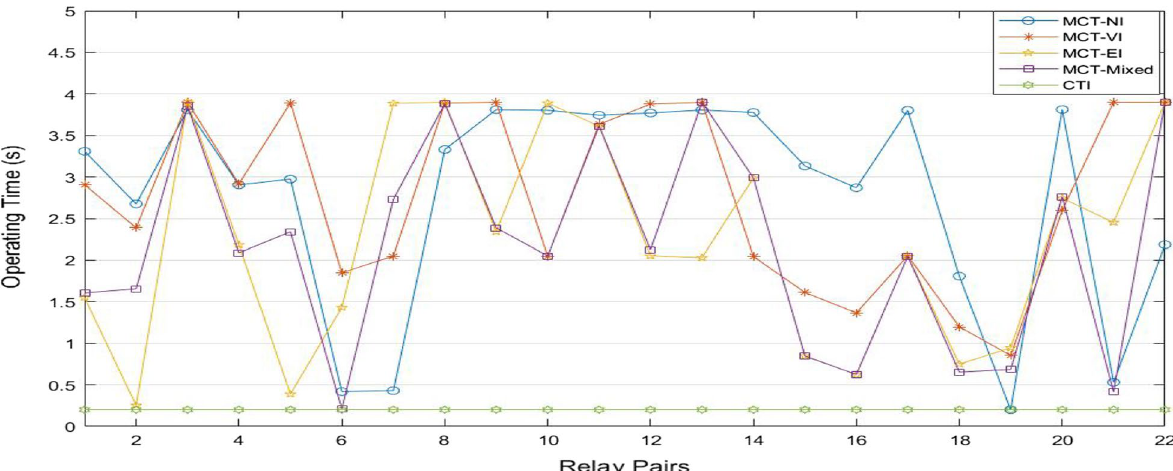
Fig. 6 MCT having NI, VI, and EI and mixed characteristics using dual setting DOCR in grid-connected mode